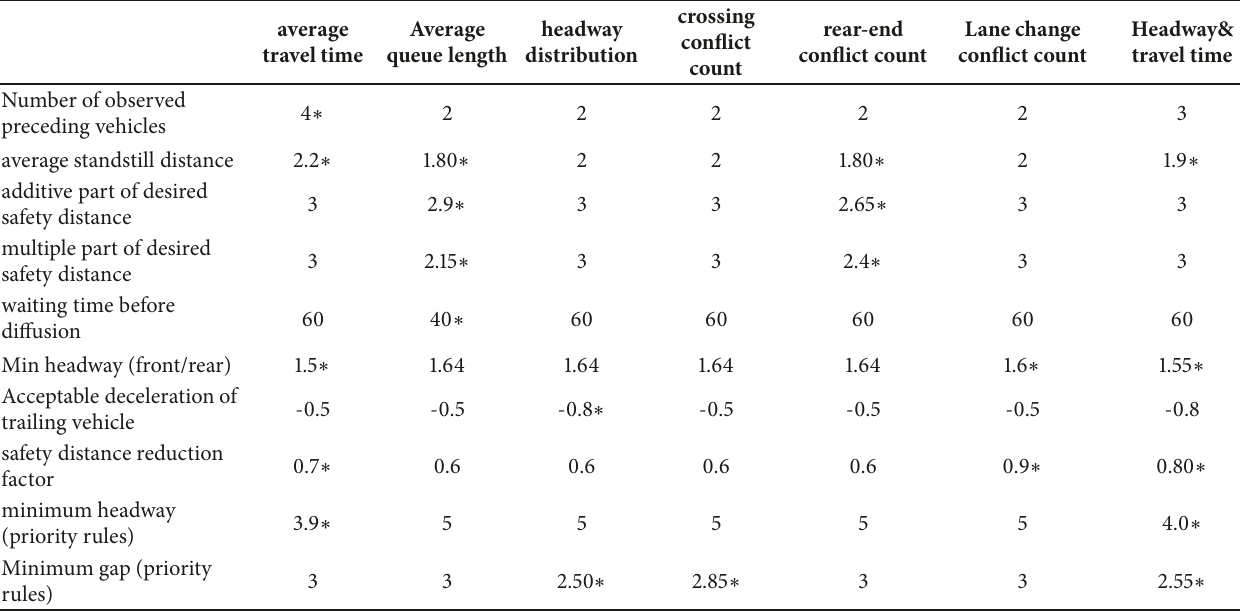
Table 5: Calibrated driving behavior parameters for validation